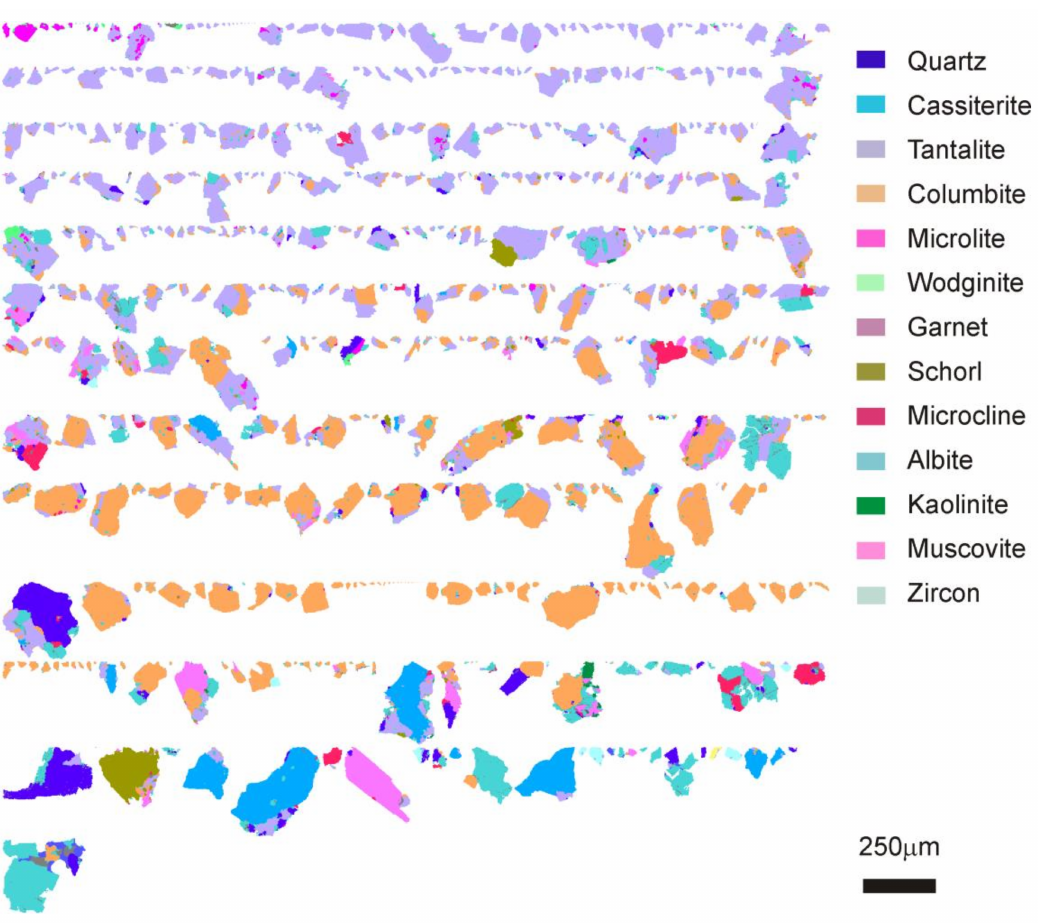
Figure 7. TIMA false color images of columbite-tantalite from concentrates of less than 250 µ m obtained from ground material using a ball mill (BM).